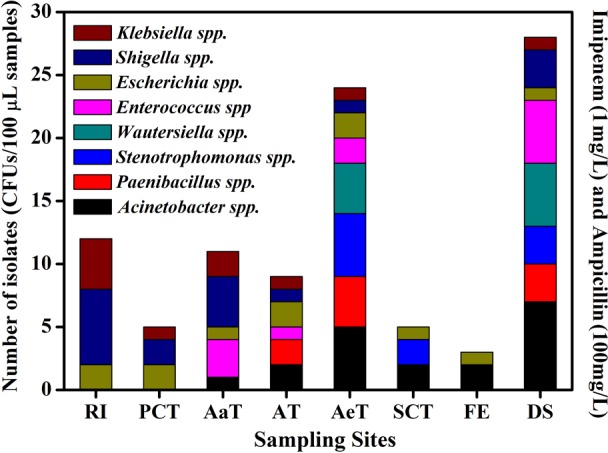
Distribution of KPC-2 producing strains at different sampling sites and with selective pressure applied.Please refer to Fig 1 for plant configuration and stage abbreviations. The numbers of isolates was represented as the CFUs per 100 μL samples from each sampling site. Species identification of these isolates was determined by 16S rRNA gene sequencing (% similarity): Klebsiella spp. (99.3%-99.6% identity to K. oxytoca strain JCM1665); Enterococcus spp. (97.4%-98.5% identity to E. faecium strain gp34); Acinetobacter spp. (98.2%-99.3% identity to A. seohaensis strain SW-100); Escherichia spp. (99.7%-99.9% identity to E. coli O157); Shigella spp. (99.4%-99.8% identity to S. sonnei strain CECT4887); Stenotrophomonas spp. (98.2%-98.8% identity to S. maltophilia R551-3); Wautersiella spp. (97.5%-98.1% identity to Wautersiella sp. MBG55); and Paenibacillus spp. (99.0%-99.2% identity to Paenibacillus sp. 1–9).